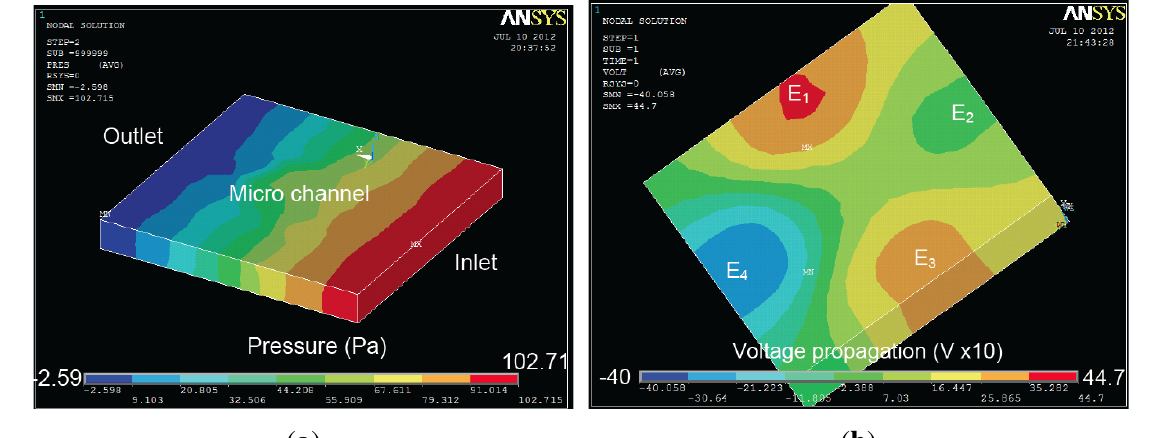
Figure 12. ANSYS results in the case of a 4-electrode architecture: ( a ) pressure and ( b ) voltage distribution in the micro-channel. Voltage distribution is multiplied by 10 in ANSYS due to simulation